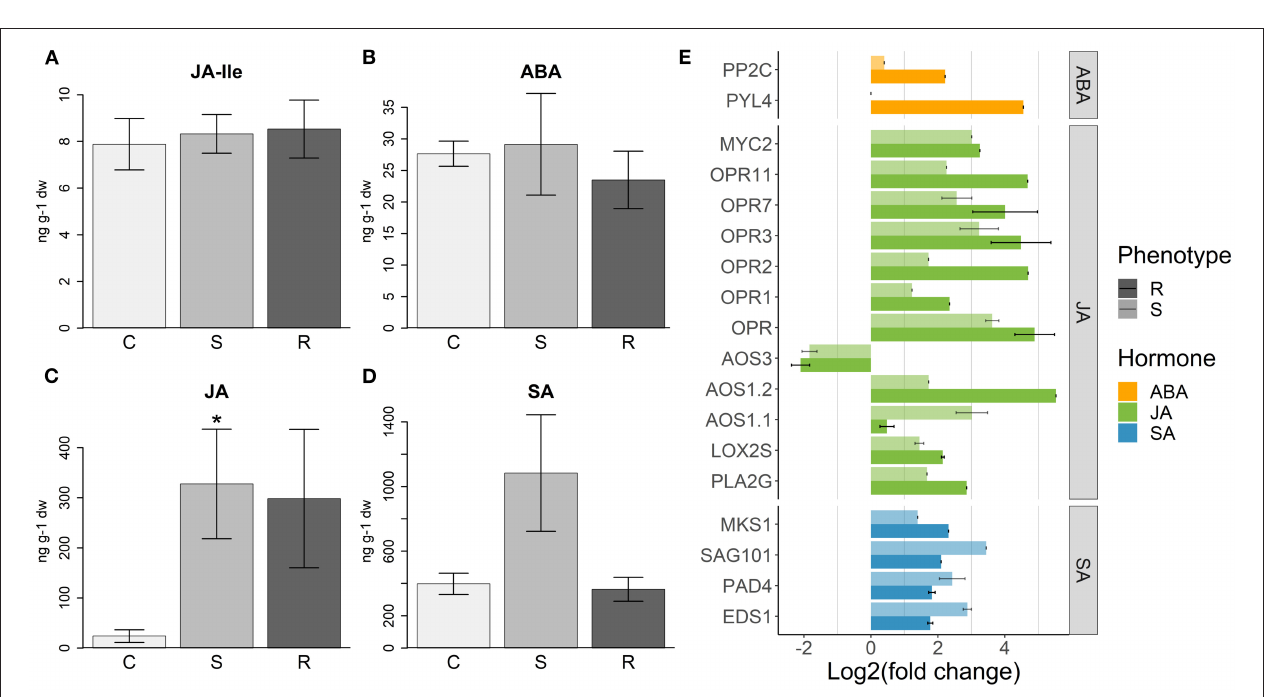
FIGURE 6 | Hormone response to PWN inoculation. (A) Levels of jasmonate-Illenine (JA-Ile), (B) abscisic acid (ABA), (C) jasmonic acid (JA), and (D) salicylic acid (SA) (ng per 1g of plant dry weight) measured in control (C), susceptible (S), and resistant (R) plants. Error bars represent the standard error of the mean. Significant differences between control and inoculated plants, using Student’s t- test, are indicated by an asterisk (* p -value < 0.05). (E) Differential expression of hormone responsive genes in resistant (R) and susceptible (S) plants, compared to controls. For each gene annotation, the average of the log2(fold change) is represented. Error bars represent the standard error of the mean. For more details about the genes used and respective functional annotations see Supplementary Table 9